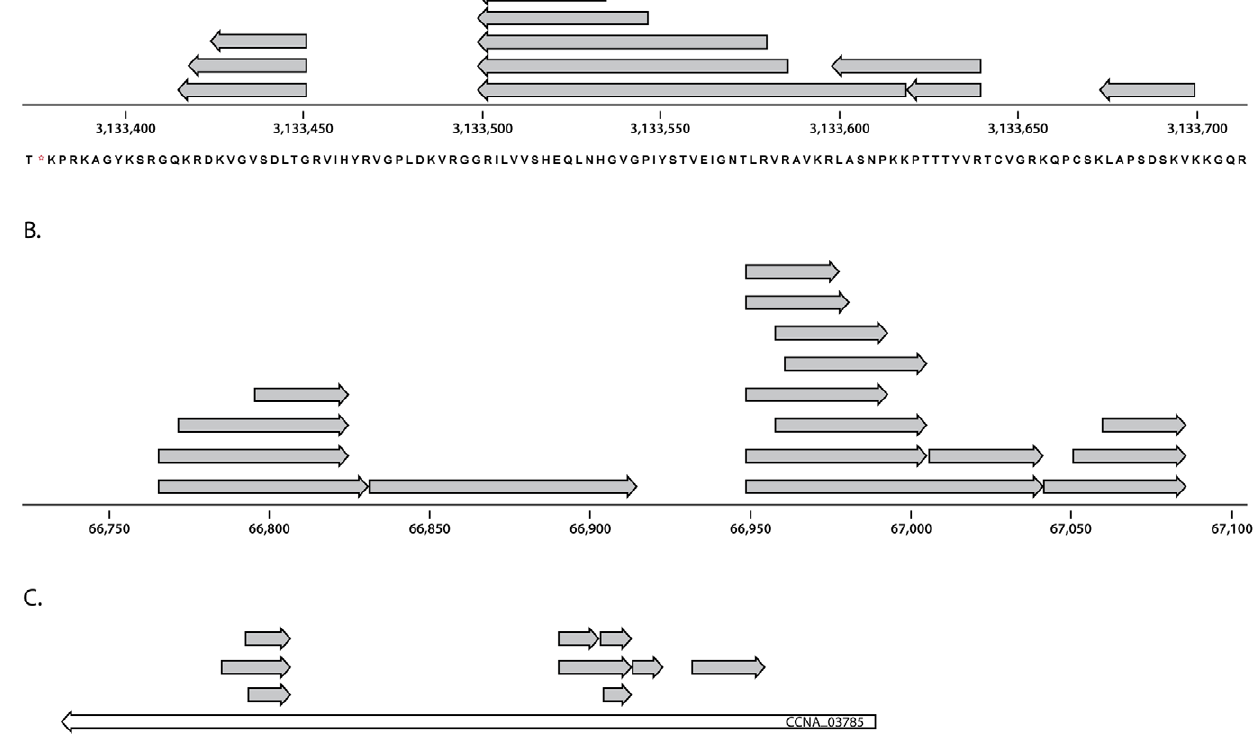
Figure 1. Novel coding content. Regions of a genome are shown where novel peptides (grey arrows) are not contained within a currently annotated protein. A, an unannotated region of Geobacter sulfurreducens corresponding to ribosomal protein S12. B, an unannotated region of Rhodobacter sphaeroides plasmid for which there are no blast matches. C, a level 3 conflict in Caulobacter crescentus . Currently annotated protein CCNA_003785 (white arrow) is dubious and should be replaced with a gene model on the opposite strand.